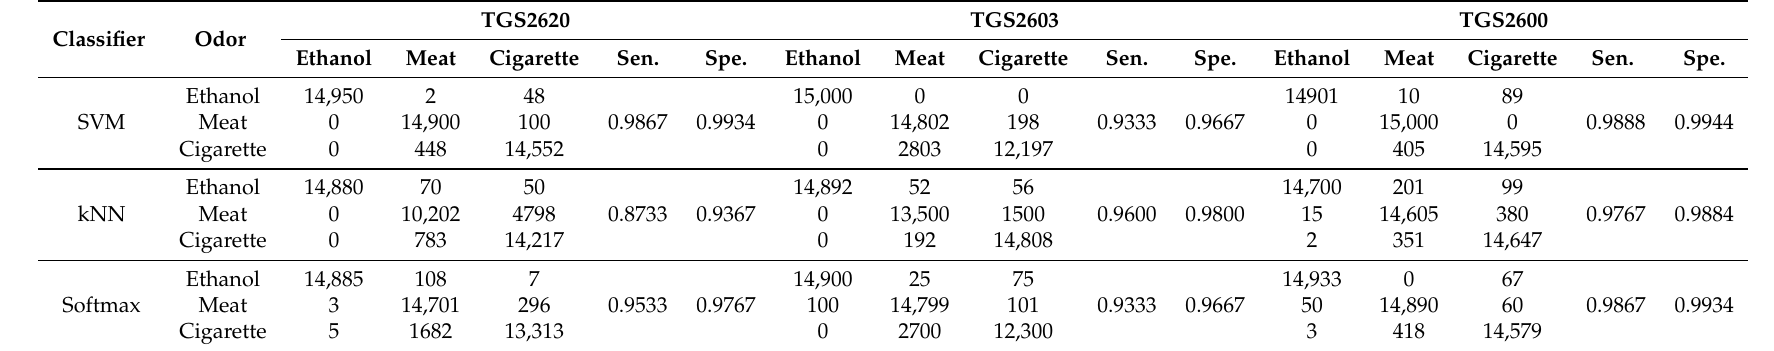
Table 3. Confusion matrix of single sensor a .